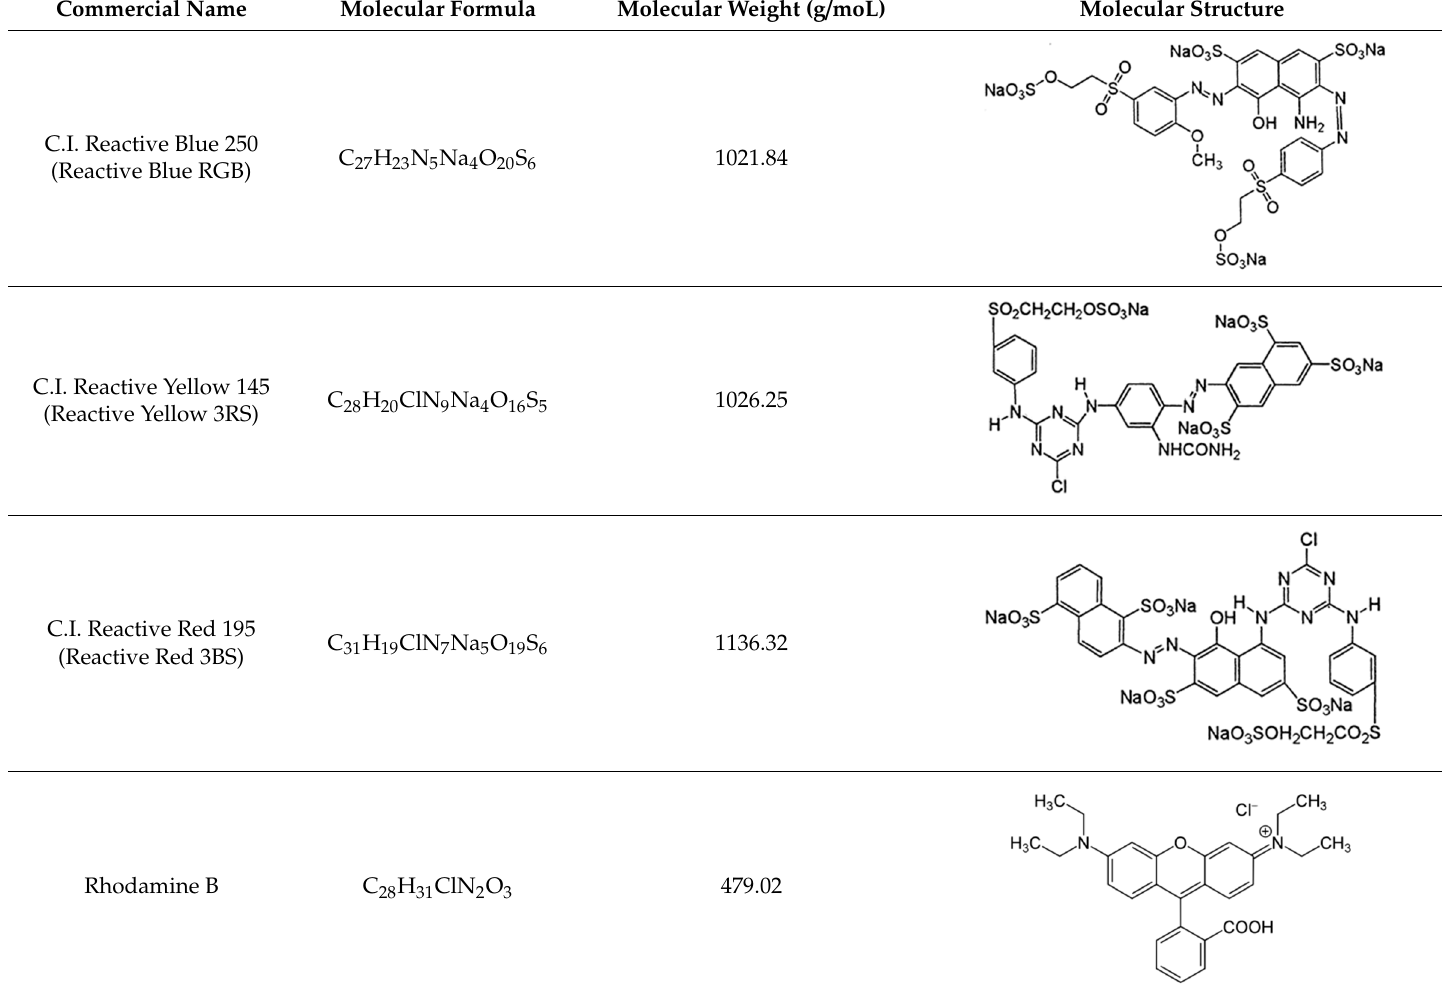
Table 1. Structure of the textile dyes and model dye used for photodegradation assays.